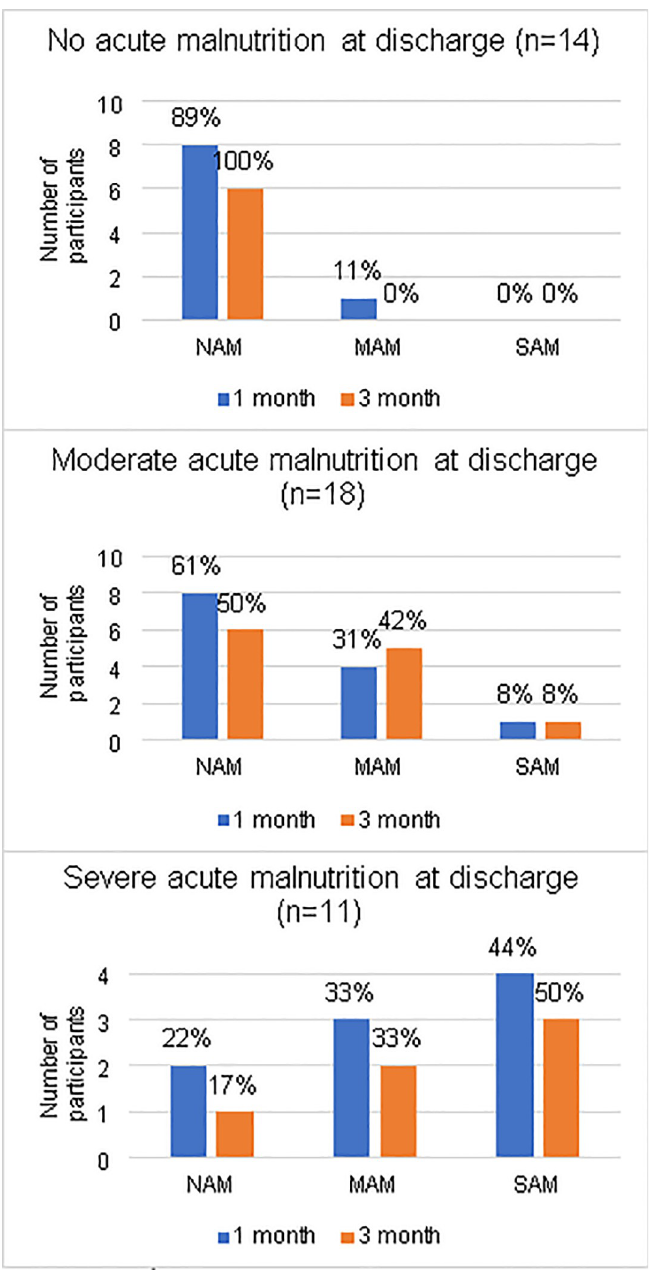
Fig 1. Anthropometric status at discharge related to one and three month follow-up status. Abbreviations: NAM = No acute malnutrition, MAM = Moderate acute malnutrition, SAM = Severe acute